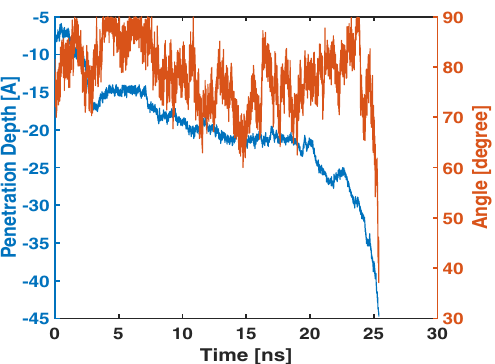
Figure 5. The penetration depth (blue line) and the orientation angle (red line) of Arg 9 vs. the simulation